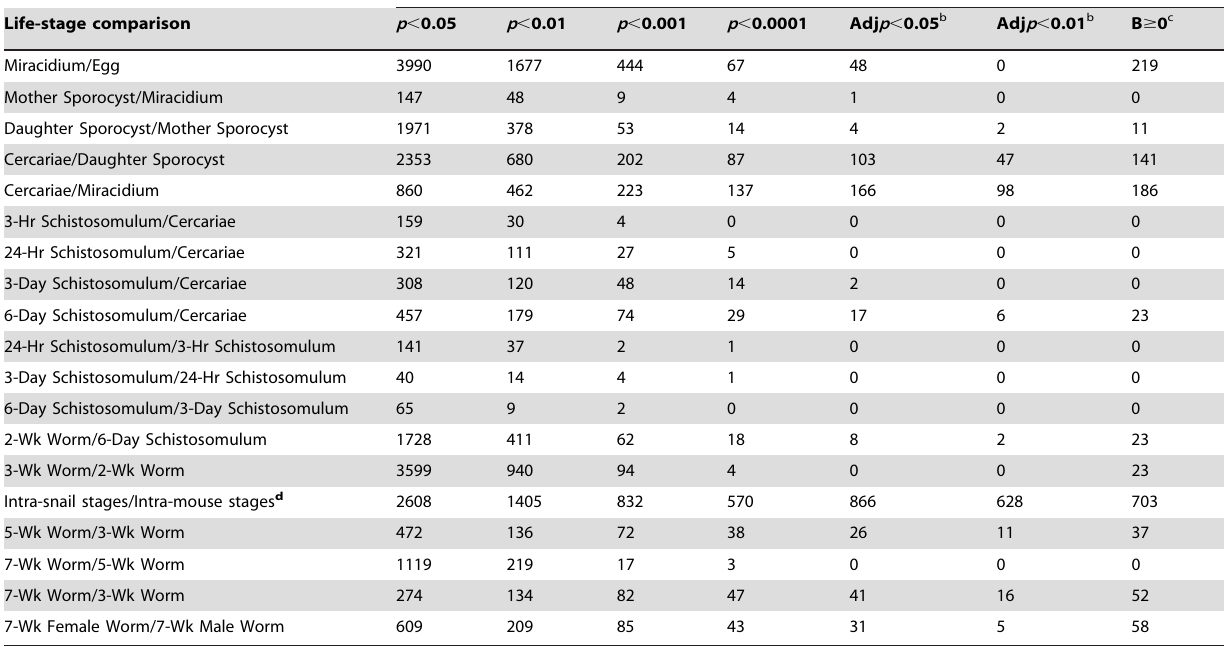
Numbers of differentially expressed transcripts identified between indicated pair wise comparison